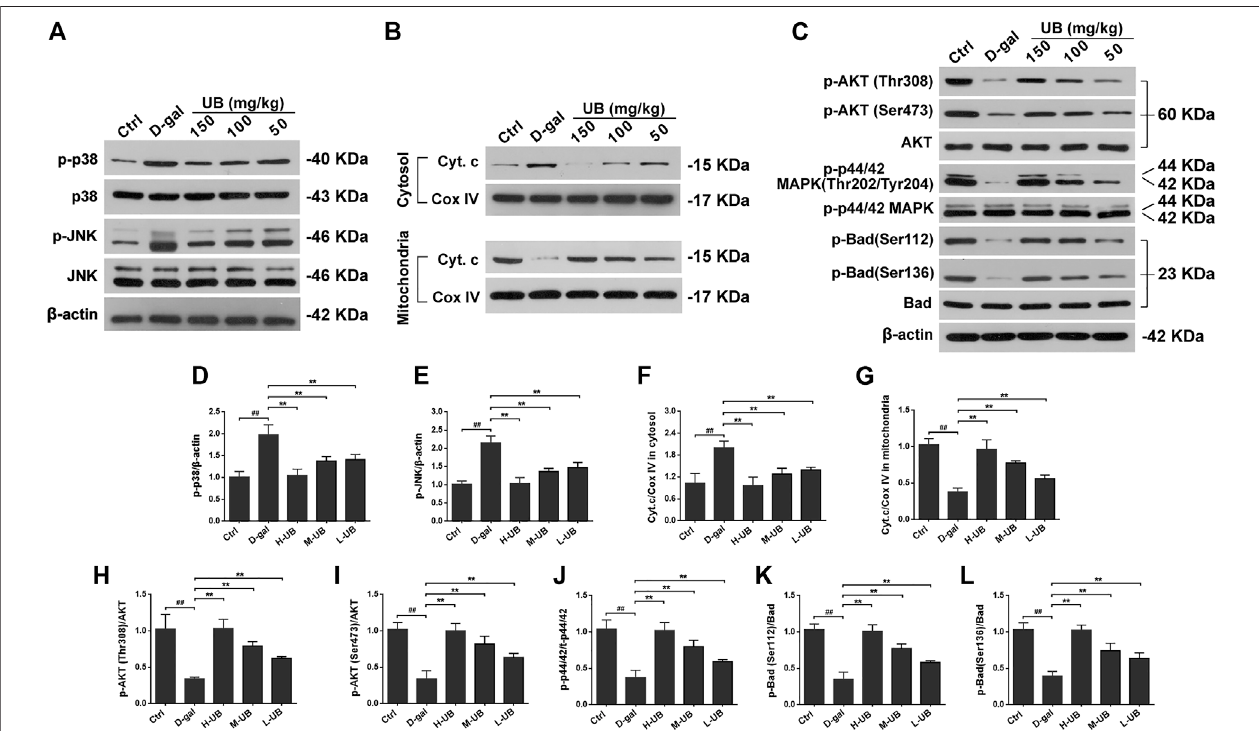
FIGURE 6 | (A) Western blots and densitometric analysis of the phosphorylation of stress-activated protein kinase (SAPK)/c-Jun NH 2-terminal kinase (JNK) and p38 MAPK in the brains of aging mice. (B) Western blots and densitometric analysis of cytosolic and mitochondrial Cyt C and COX IV in all treated groups. (C) Western blots and densitometric analysis of the phosphorylation of Akt, p44/42 MAPK and Bad in the brains of D-gal-treated aging mice. Quanti fi cation analysis of p-p38 (D) , p-JNK (E) ,Cyt.c/COXIV incytosolic (F) and mitochondrial (G) ,p-Akt (Thr308)/Akt (H) ,p-Akt(Ser473)/Akt (I) ,p-p44/42/t-p44/42 (J) ,p-Bad (Ser112)/Bad (K) and p-Bad (Ser136)/Bad (L) . Data were normalized to β -actin protein expression ( n (cid:1) 6 per group). All results are described as means ± SD. # p < 0.05 and ## p < 0.01 vs the control group; * p < 0.05 and ** p < 0.01 vs the D-gal-induced aging